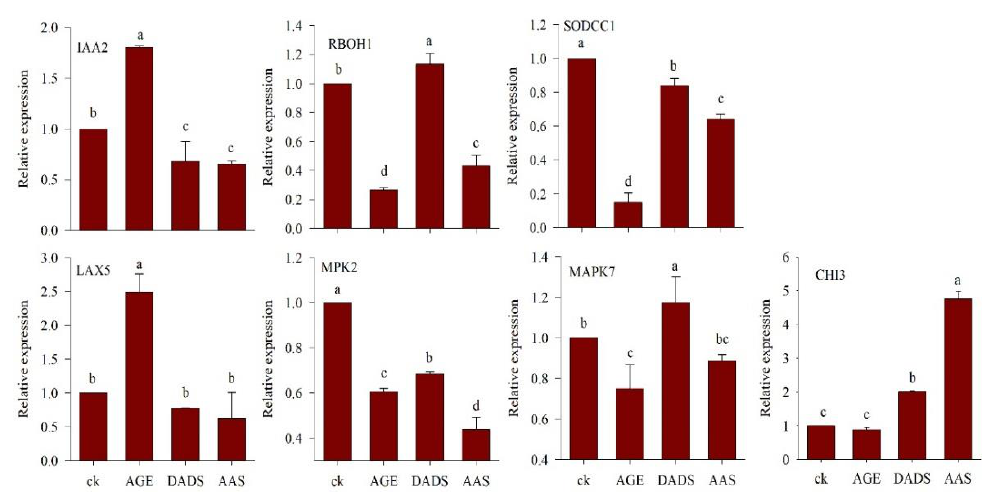
Figure 7. Relative expression of various genes in tomato seedlings germinated after priming with AGE (100 µ g · mL − 1 ), DADS (0.029 µ g · mL − 1 ), and AAS (100 µ g · mL − 1 ) relative to water control (1.0). The relative expressions of di ff erent genes are presented as means and standard errors of three biological replications. Data were subjected to ANOVA and the comparison to control was analyzed using the least significant di ff erence (LSD) and Dunnett’s multiple comparison with a control test.